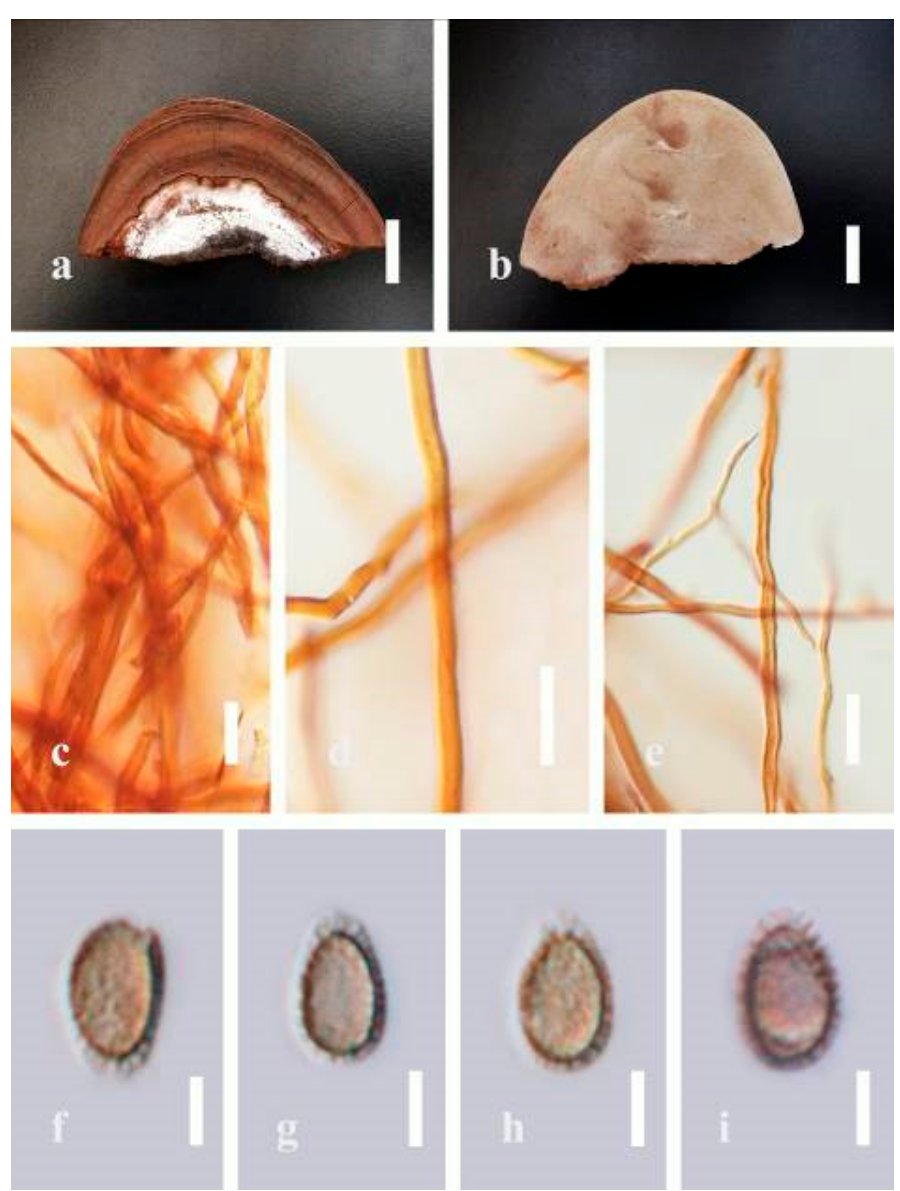
Figure 17. Morphology of Ganoderma australe (MFLU 19 ‐ 2171): ( a , b ) mature basidiomes; ( c – e ) con ‐ text hyphae in KOH; ( f – i ) basidiospores. Scale bars: ( a , b ) = 2 cm, ( c – e ) = 20 μ m, ( f – i ) = 5 μ m. Ganoderma gibbosum (Blume and T. Nees) Pat., Ann. Jard. Bot. Buitenzorg, suppl. 1: Hyphal structure: Hyphal system trimitic, with clamp connections, usually brownish- 114 (1897) (Figure 18) orange (6C5–6C7) in KOH; generative hyphae 2.0–3.4 µ m broad ( n = 30), thin-walled, Facesoffungi number: FoF 06243